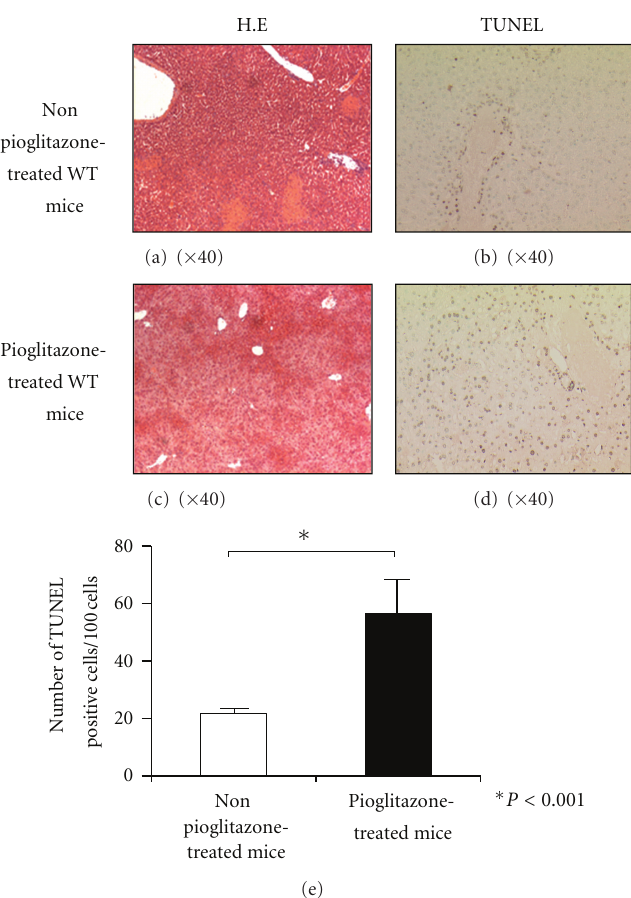
Figure 3: Histopathological examination of liver sections stained with H-E at 20 h after Con A injection revealed more extensive liver necrosis in the pioglitazone-treated mice (c) in comparison with that in the nonpioglitazone-treated mice (a). TUNEL assay at 20h after Con A injection revealed more extensive liver apoptosis in the pioglitazone-treated mice (d) as compared with that in the nonpioglitazone- treated mice (b). The number of TUNEL-positive cells/100 cells was three-times higher in the livers of the pioglitazone-treated mice as compared with that in the livers of the nonpioglitazone-treated mice (56 ± 8 . 01 versus 21 ± 1 . 83, P < 0 .